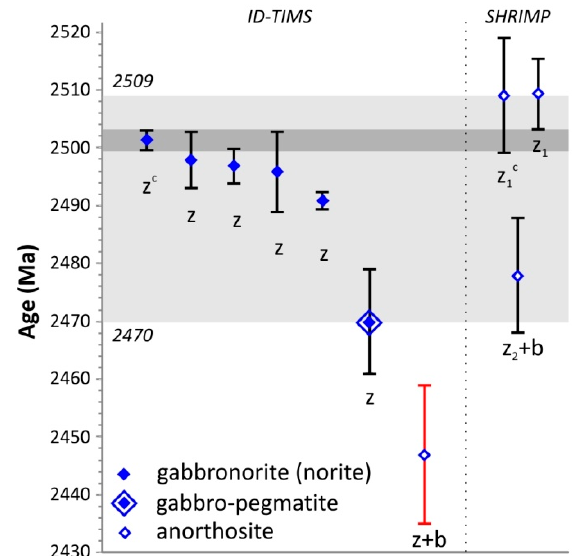
Figure 8. Overview of published U-Pb zircon (z) and baddeleyite (b) ages from different West-Pana lithologies. See Table 2 for references; C, mean 207 Pb/ 206 Pb age or concordia age. Note that the upper intercept age for magmatic zircon (z 1 ) from the Main Anorthosite Layer (2509.4 ± 6.2 Ma) is older than the mean 207 Pb/ 206 Pb age of the lower part of the intrusion (2501.5 ± 1.7 Ma, dark grey field), potentially indicating that (1) the upper portion of the intrusion is older than the lower portion and (2) the previous ID-TIMS date for this lithological unit (red error bar) did not record the actual crystallization age.